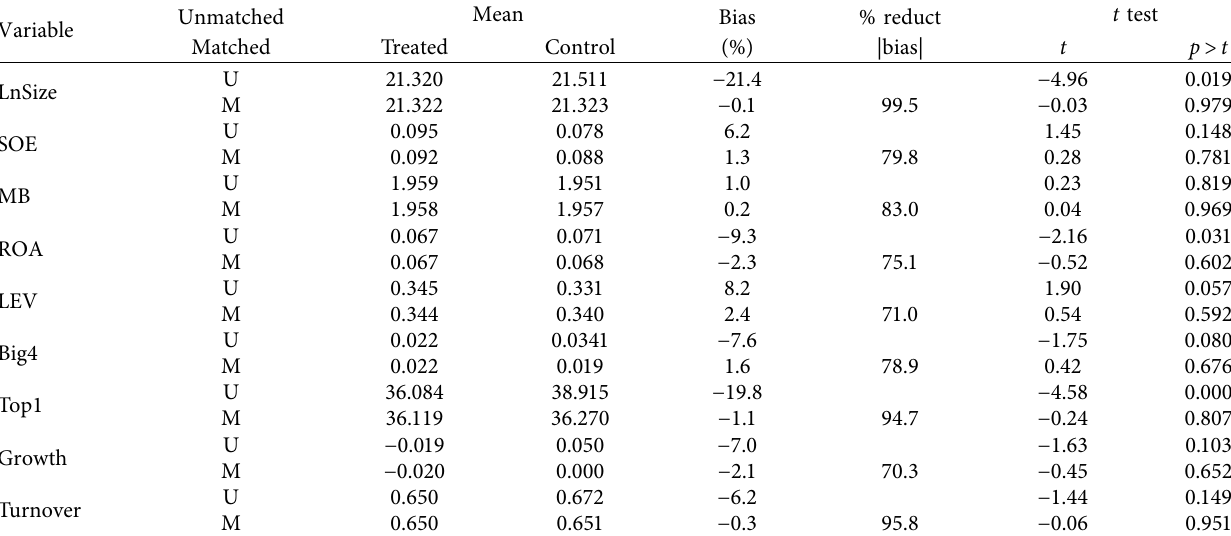
Table 6: Covariate balance testing